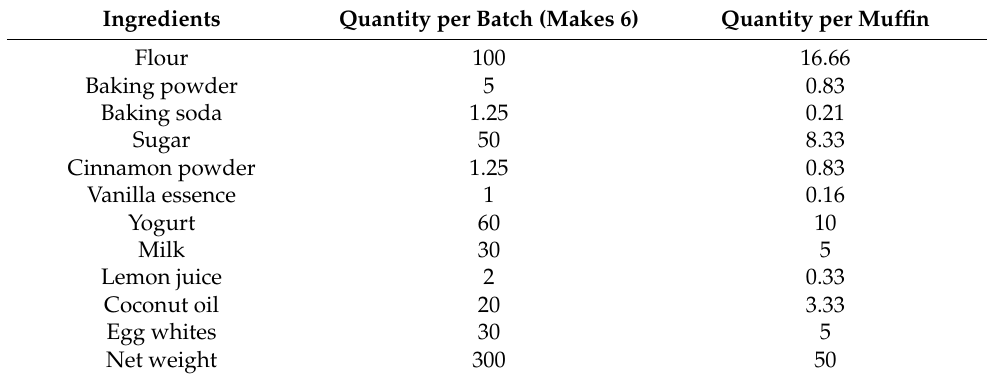
Table 7. List of ingredients (g) for standard/control recipe of